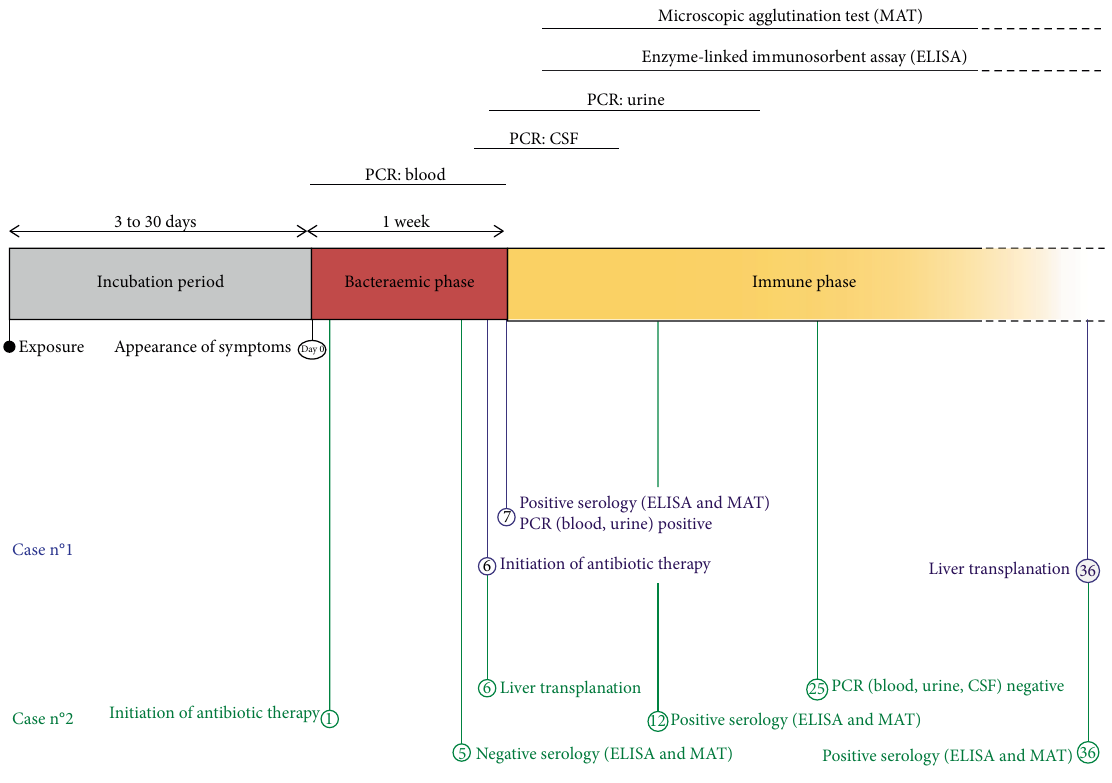
Figure 1: Timeline of leptospirosis management: diagnostic tests, clinical data, and test results for two